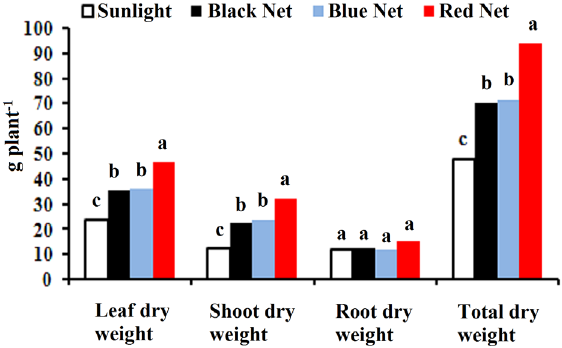
Figure 1 - Leaf dry weight (LDW), shoot dry weight (SDW), root dry weight (RDW) and total dry weight (TDW) of P. cablin grown under full sun and under black, blue and red nets at 50%